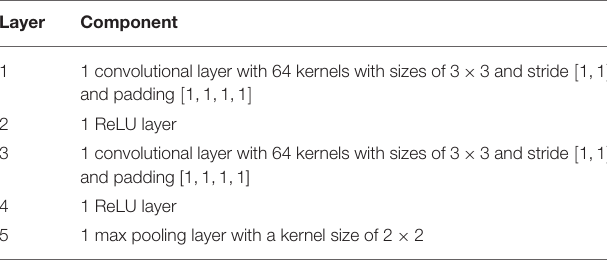
TABLE 2 | Components of 1st CB “2 Layer Component